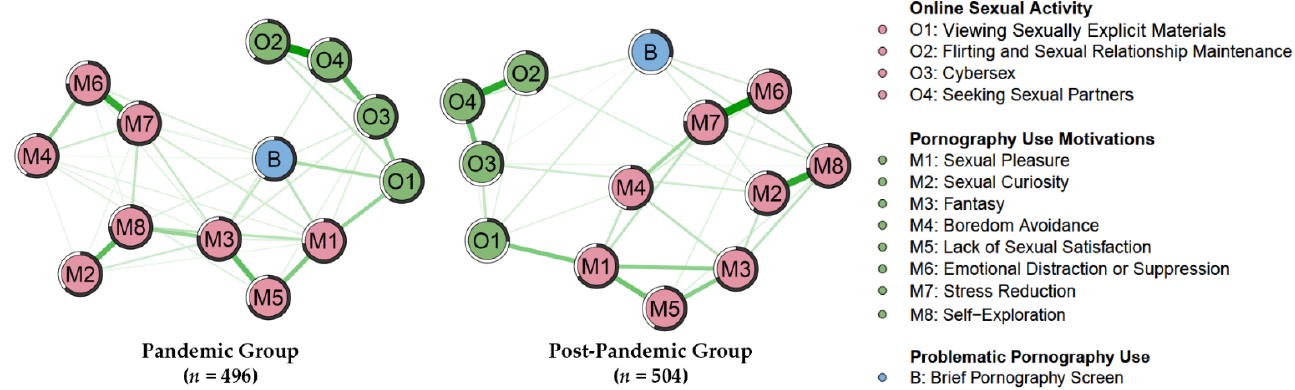
Figure 1. Network topology for PUM, OSA, and BPS by group. Green color edges represent positive, and red color edges represent negative associations, all lines in both networks are green. Thickness and saturation of edges indicate the strength of associations. The filled part of the pie chart around each node shows the predictability of each node, representing the variance of the nodes explained by other nodes in the